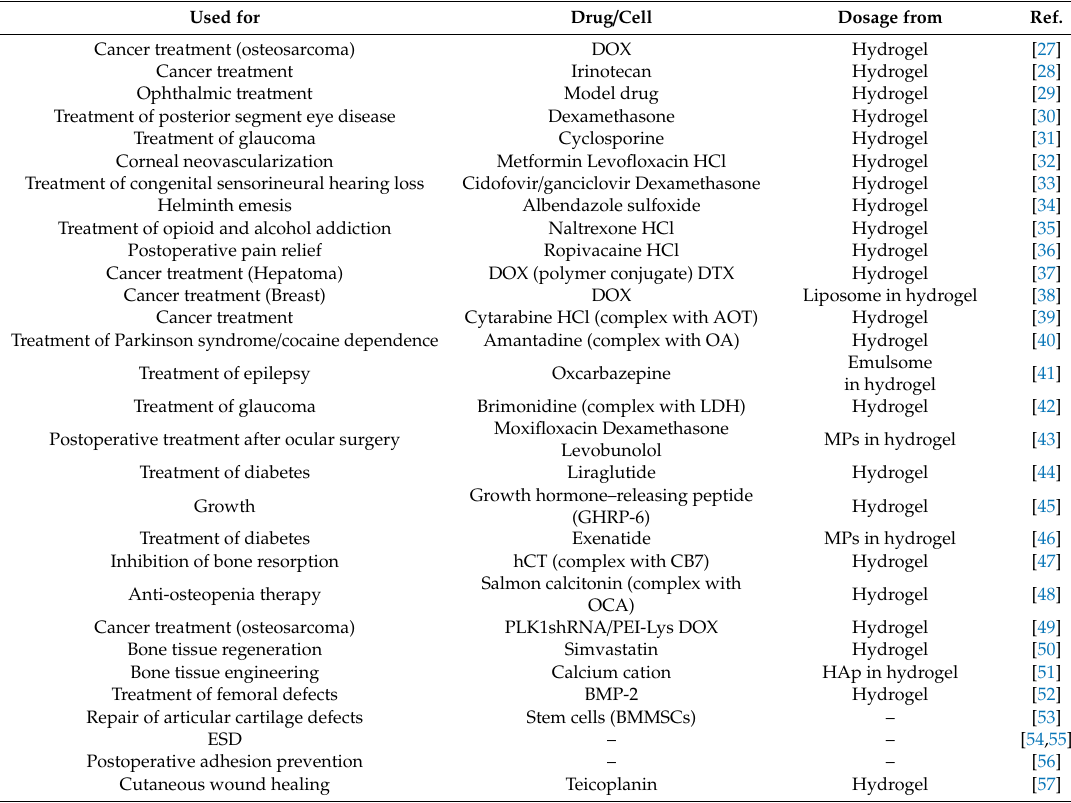
Table 3. Biomedical applications of thermoresponsive hydrogels using block copolymers with PEG and PLGA